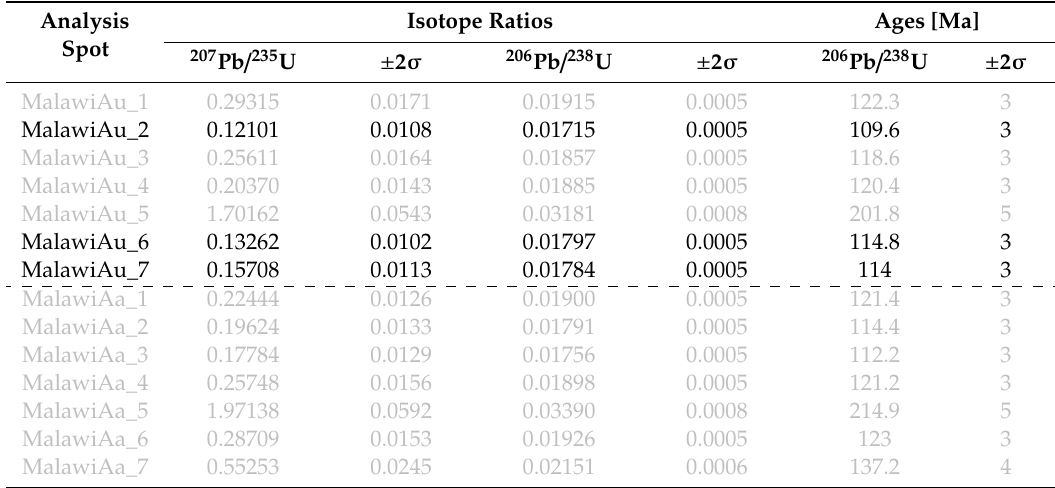
Table A6. U-Pb isotope ratios and 206 Pb / 238 U ages of the large, heterogeneous zircon crystal MalawiA from the Mt. Malosa Massif, Malawi with multiple analyses spots on both, the radiation damage-a ff ected unannealed half (u) and the heat-treated annealed half